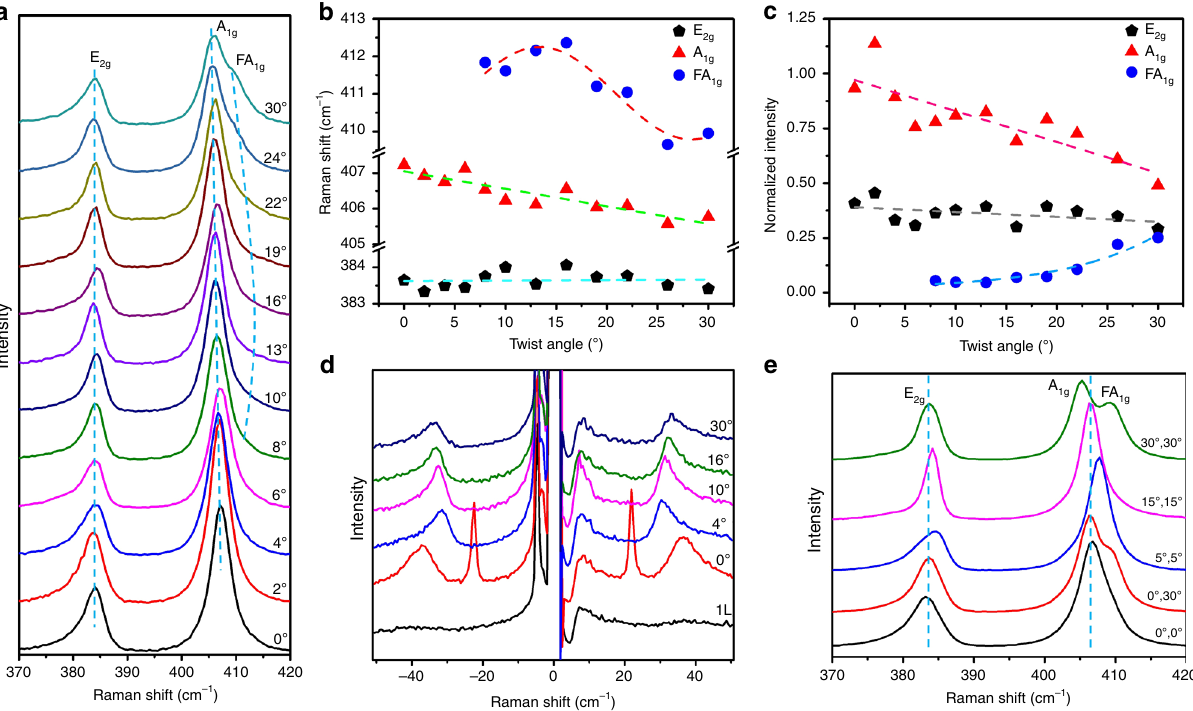
Fig. 4 Raman characterizations of the twisted bilayer and trilayer MoS 2 fi lms. a Raman spectra of a series of transferred bilayer MoS 2 fi lms with controlled twist angle, each Raman spectrum was calibrated and normalized by the position and intensity of silicon peak at 520.7 cm − 1 . b The position of E A A 2g , 1g, and F 1g Raman peaks as a function of twist angle, dash lines are linear ( Raman peaks as a function of twist angle, dash lines are linear ( E 2g , A 1g ) and exponential (F A 1g ) fi tting. d Low-wavenumber Raman spectra of monolayer and bilayer twisted MoS 2 fi lms. e Raman spectra of trilayer twisted MoS 2 fi lms with different twist con fi guration. Source data are provided as a Source Data fi